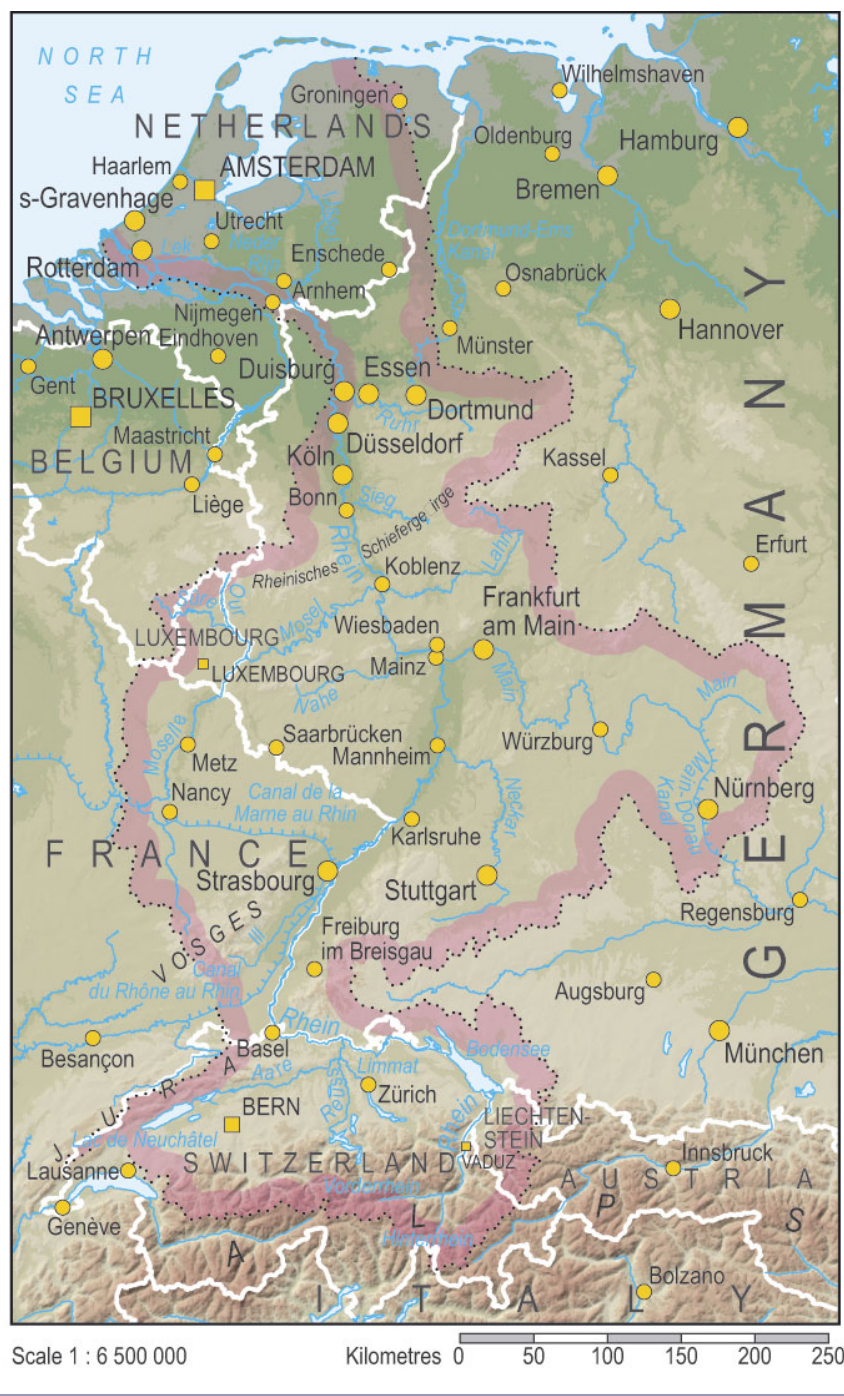
Fig. 5. Map of the Rhine basin (UNEP/DEWA/GRID-Europe, Retrieved 22 August 2007 from http://ww